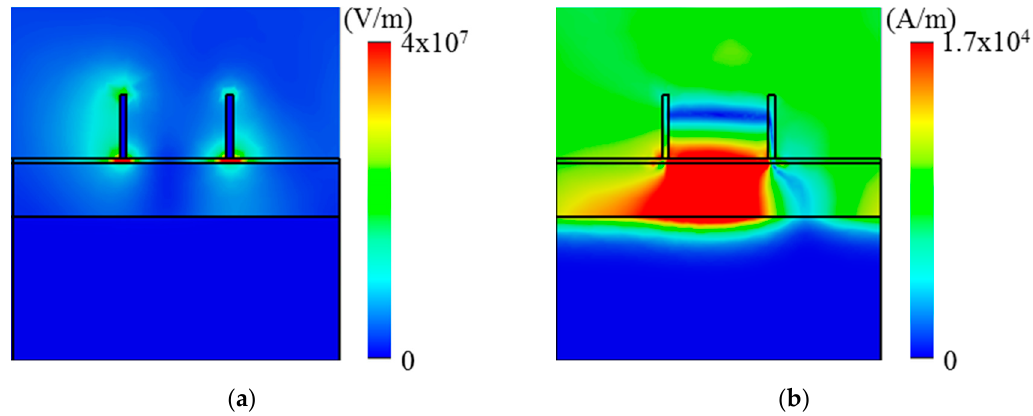
Figure 4. ( a ) E-field magnitude distribution (in units of V/m) indicating ENZ mode at 7.9 μ m wavelength and ( b ) H-field magnitude distribution (in units of A/m) indicating the gap plasmon mode at 8.9 μ m wavelength within the perfect absorption band.